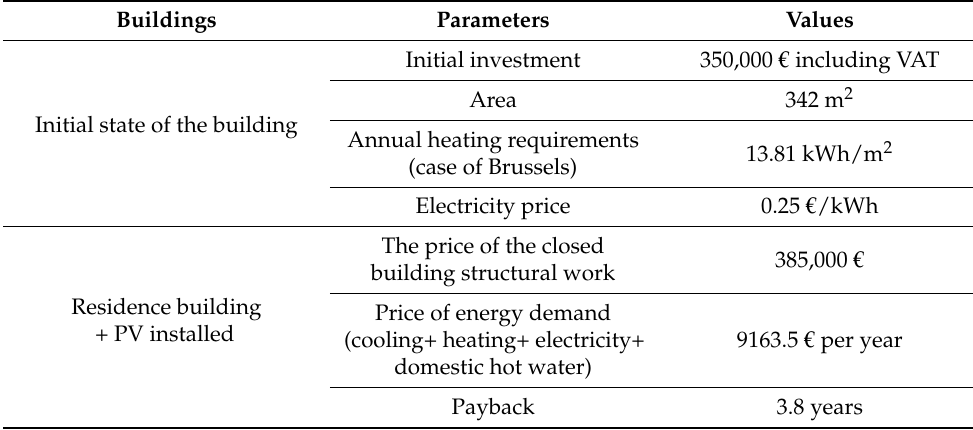
Table 12. Evaluation of